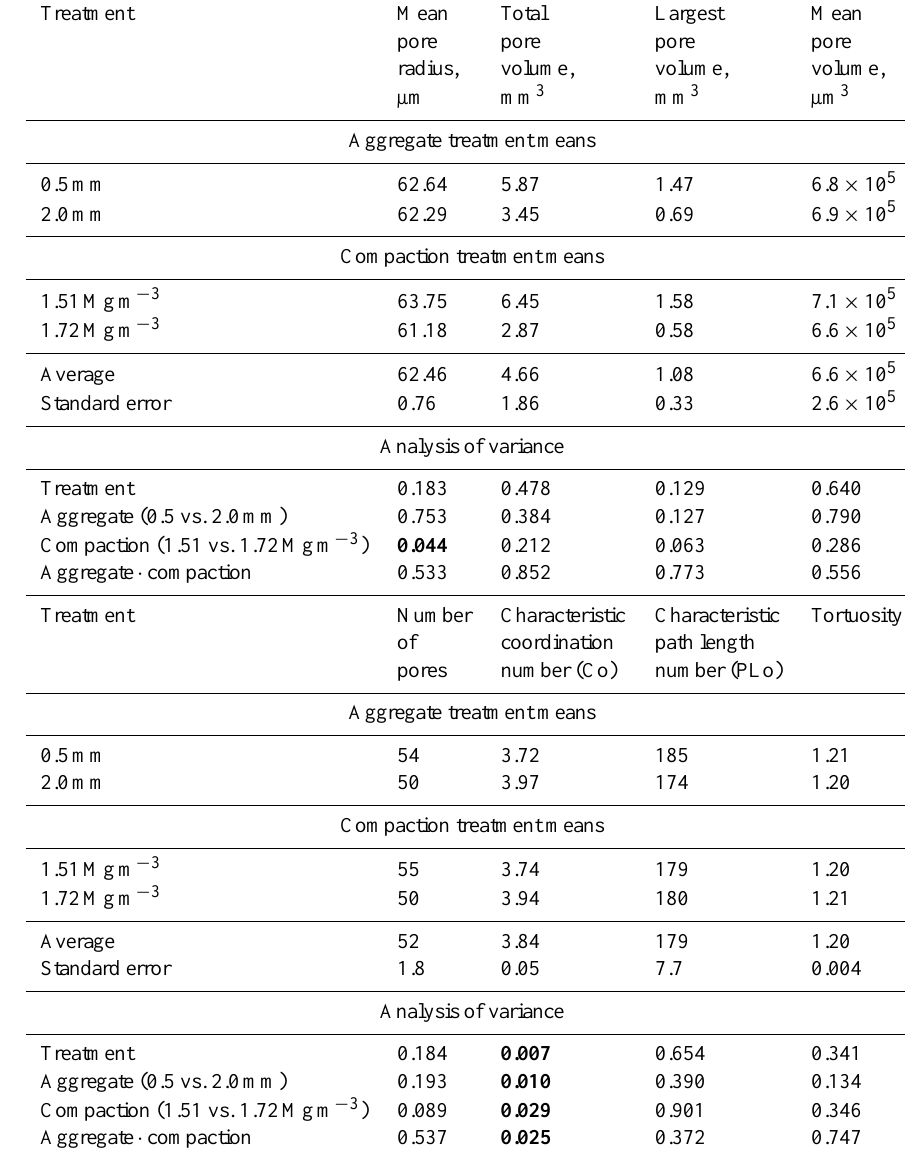
Table 1. Geometrical pore parameters (pore radius, pore volume, number of pores, characteristic coordination number, characteristic path length, and tortuosity) as influenced by aggregate size and compaction treatments and ANOVA. Soil cores were scanned at the GeoSoilEn- viroCARS (GSECARS) sector at the Argonne Advanced Photon Source X-ray computed microtomography facility. Bold numbers denote significant differences at the 0.05